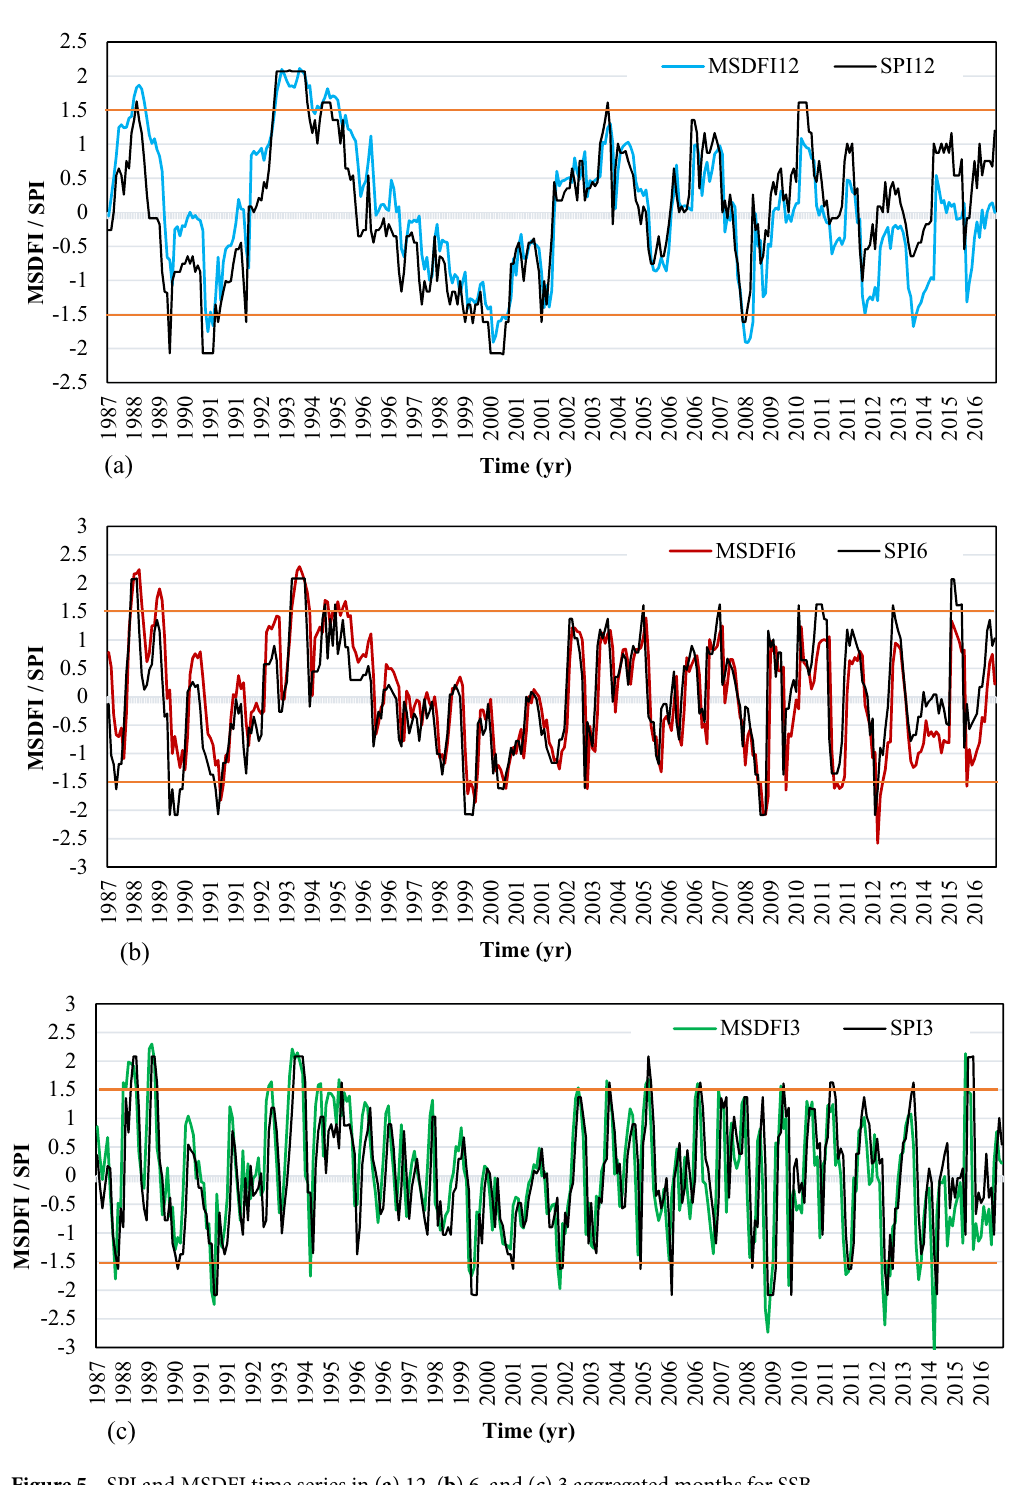
Figure 5. SPI and MSDFI time series in ( a ) 12, ( b ) 6, and ( c ) 3 aggregated months for